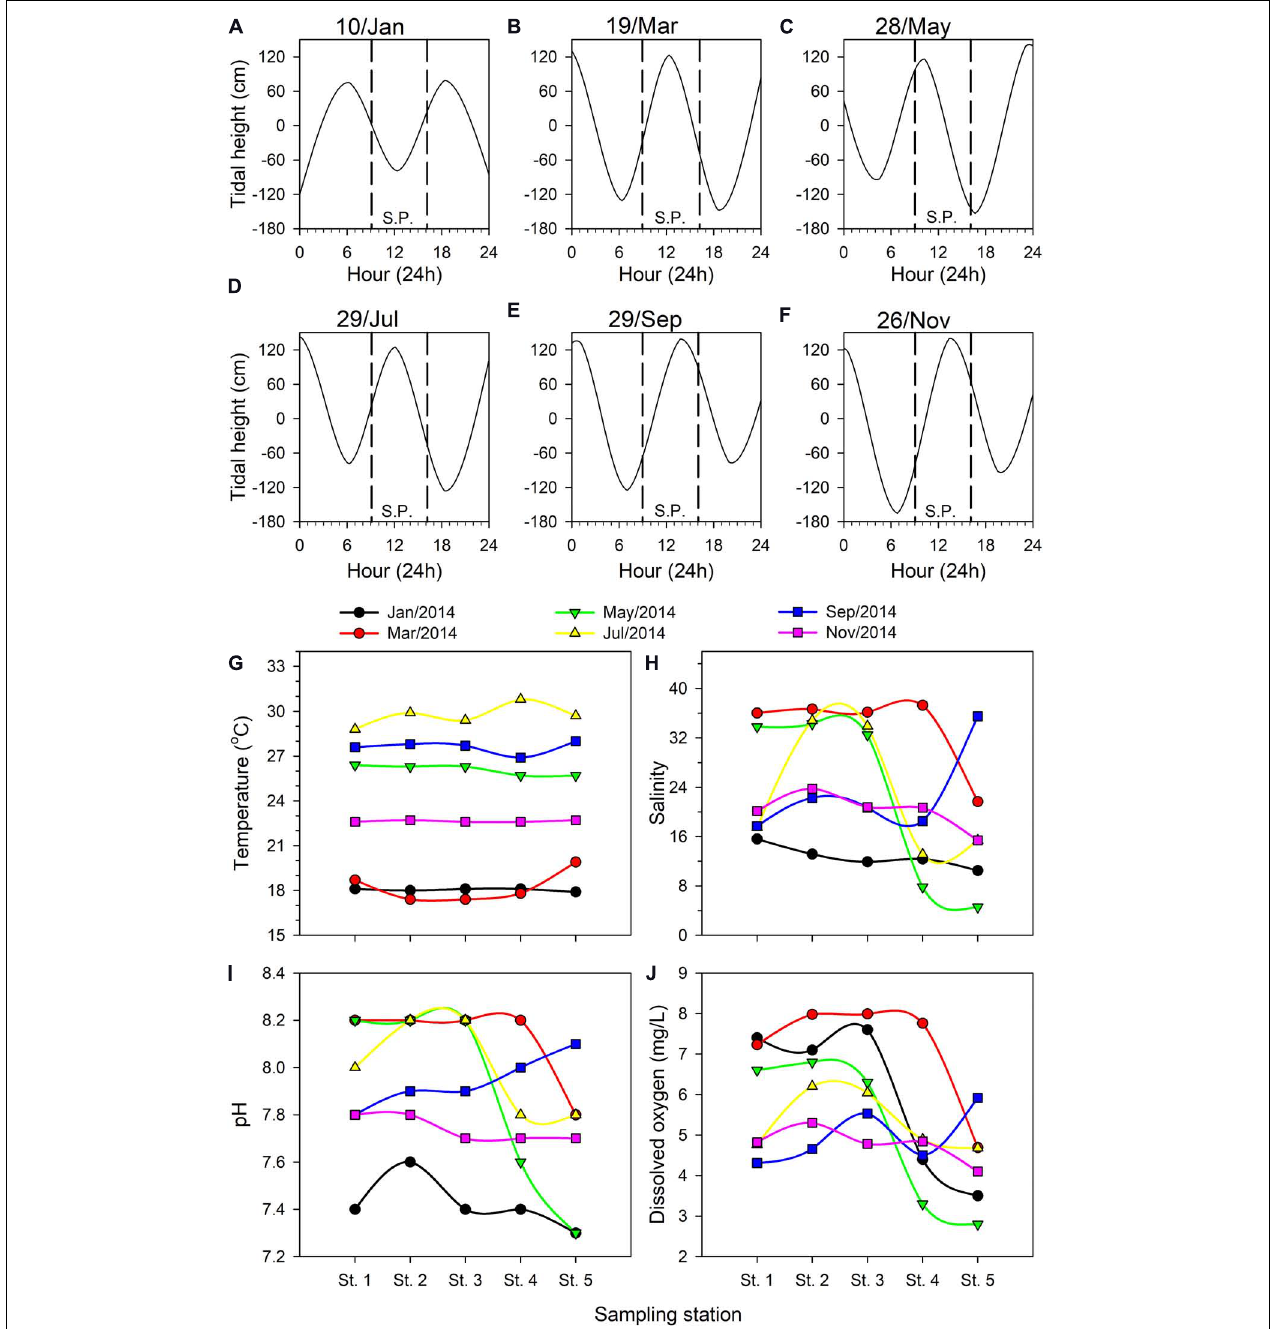
FIGURE 3 | Tidal height (cm) fluctuations on each bimonthly sampling date in 2014 in the Danshuei River estuary: January 10 (A) , March 19 (B) , May 28 (C) , July 29 (D) , September 29 (E) , and November 26 (F) . Upstream-downstream variation in hydrographic parameters among the sampling stations in this estuary on each bimonthly sampling date: water temperature (G) , salinity (H) , pH (I) , dissolved oxygen concentration (J) . SP, sampling